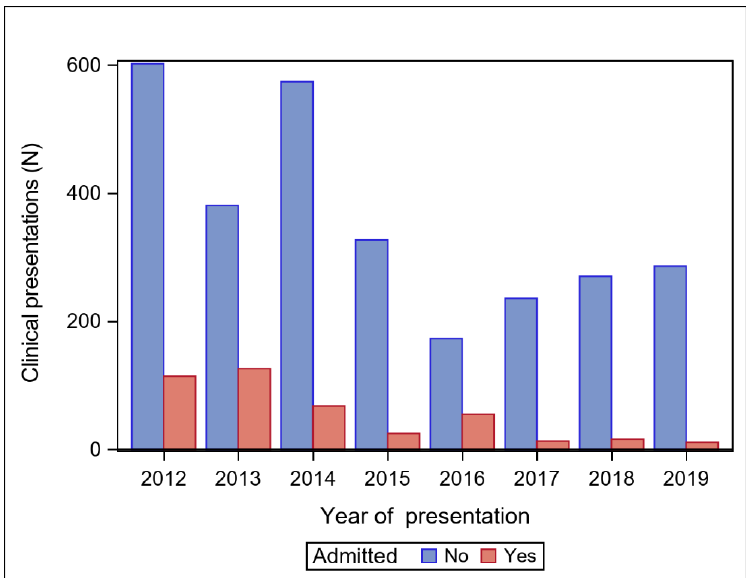
Figure 1. Lassa fever screenings at Kenema Government Hospital by admission status, 2012–2019. Note. Admitted refers to subjects admitted to KGH Lassa Fever Ward following confirmed Lassa fever diagnosis.